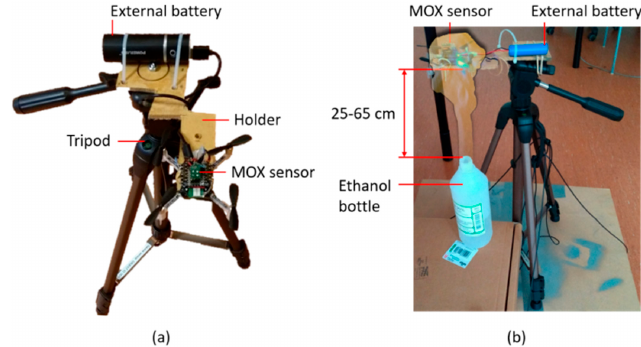
Figure 8. Setup for assessing the effect of the rotors on the MOX sensor signals. ( a ) Top view of the stand used to hold the drone at different heights while minimizing interference with the rotors air flow; ( b ) Photo of an experiment with the drone placed 25 cm above an ethanol bottle (gas source), overlaid with an illustration of a gas cloud.